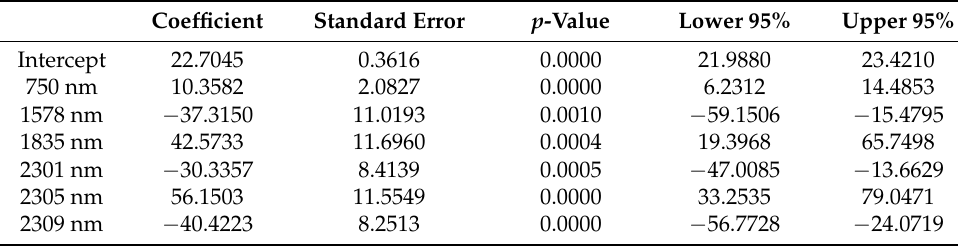
Table 2. t -test on the regression coefficients of the model.